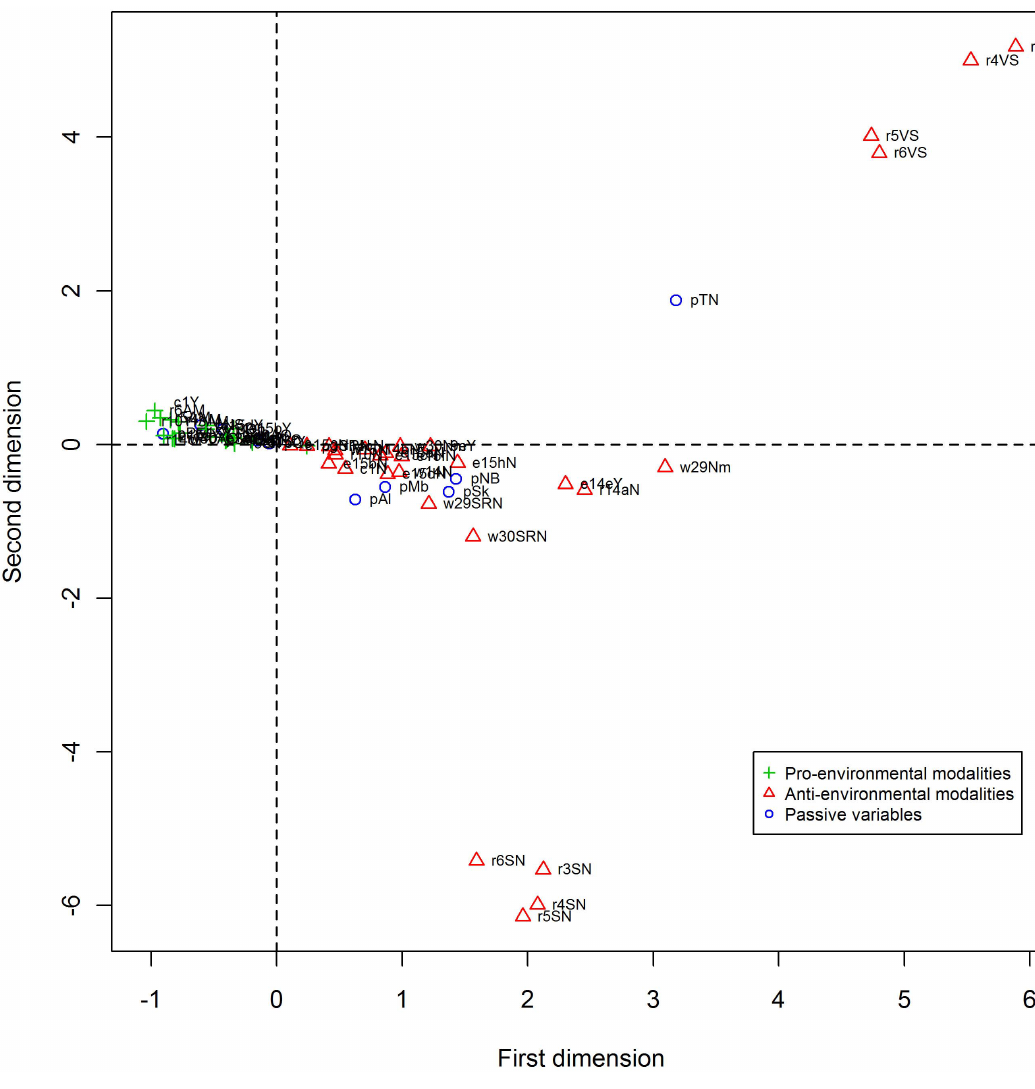
Figure 3. Map representation of the MCA results on the 23 questions of the group A (Indoor).